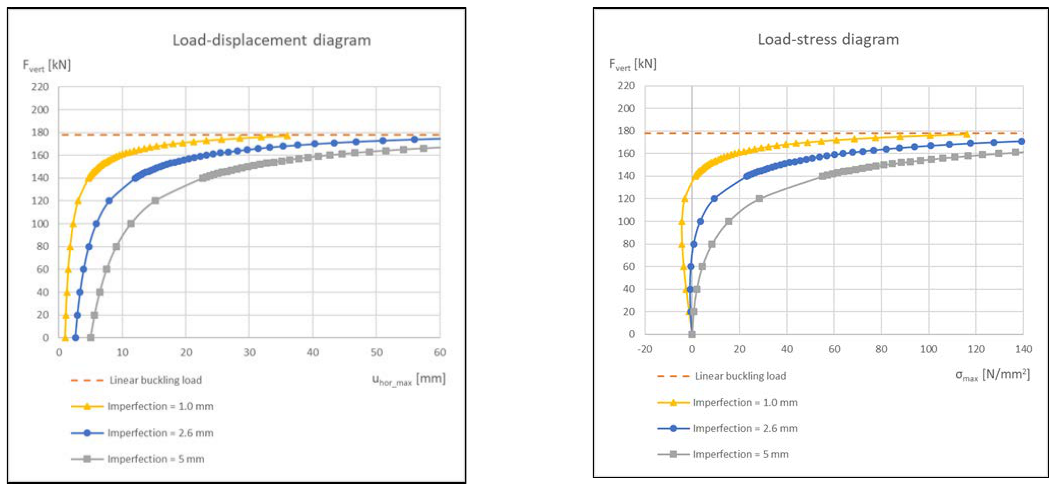
Fig. 9 load-displacement and load-stress diagrams for different values for the initial